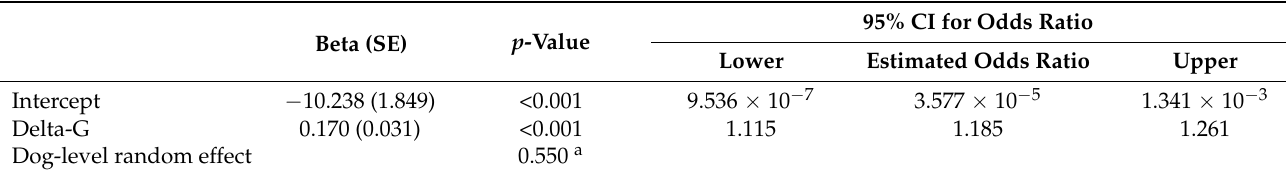
Table 3. Results from a mixed-effects logistic regression model predicting BGV with delta-G, with repeat measurements in individual dog accounted for with an intercept-only random